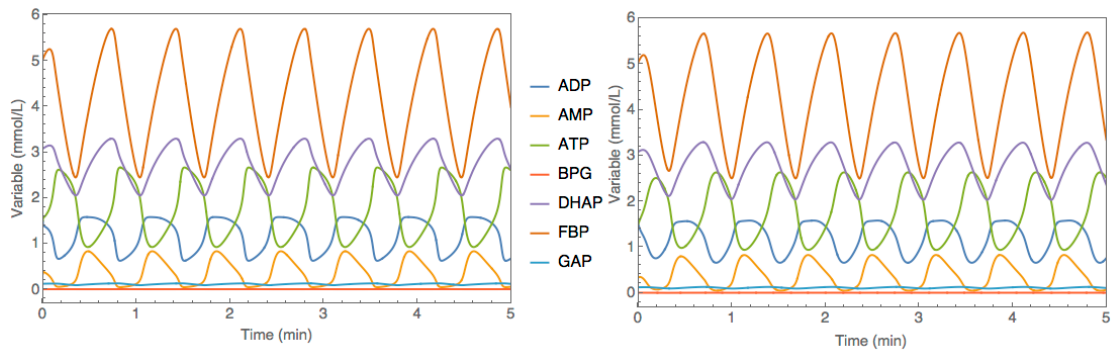
Figure 7. Comparison between original model and best hybrid model for case study 3 (yeast glycolysis model). Dynamic profiles were simulated based on the respective SBML files on the JWS Online platform. Simulations were performed for the center point experiment of the CC-DOE (not used for training). Full lines represent species concentrations over time. Left panel: Original SBML model simulation. Right panel: Best hybrid model simulation with structure [7 × 10 × 10 × 10 × 11] (Sixth row of Table 4).